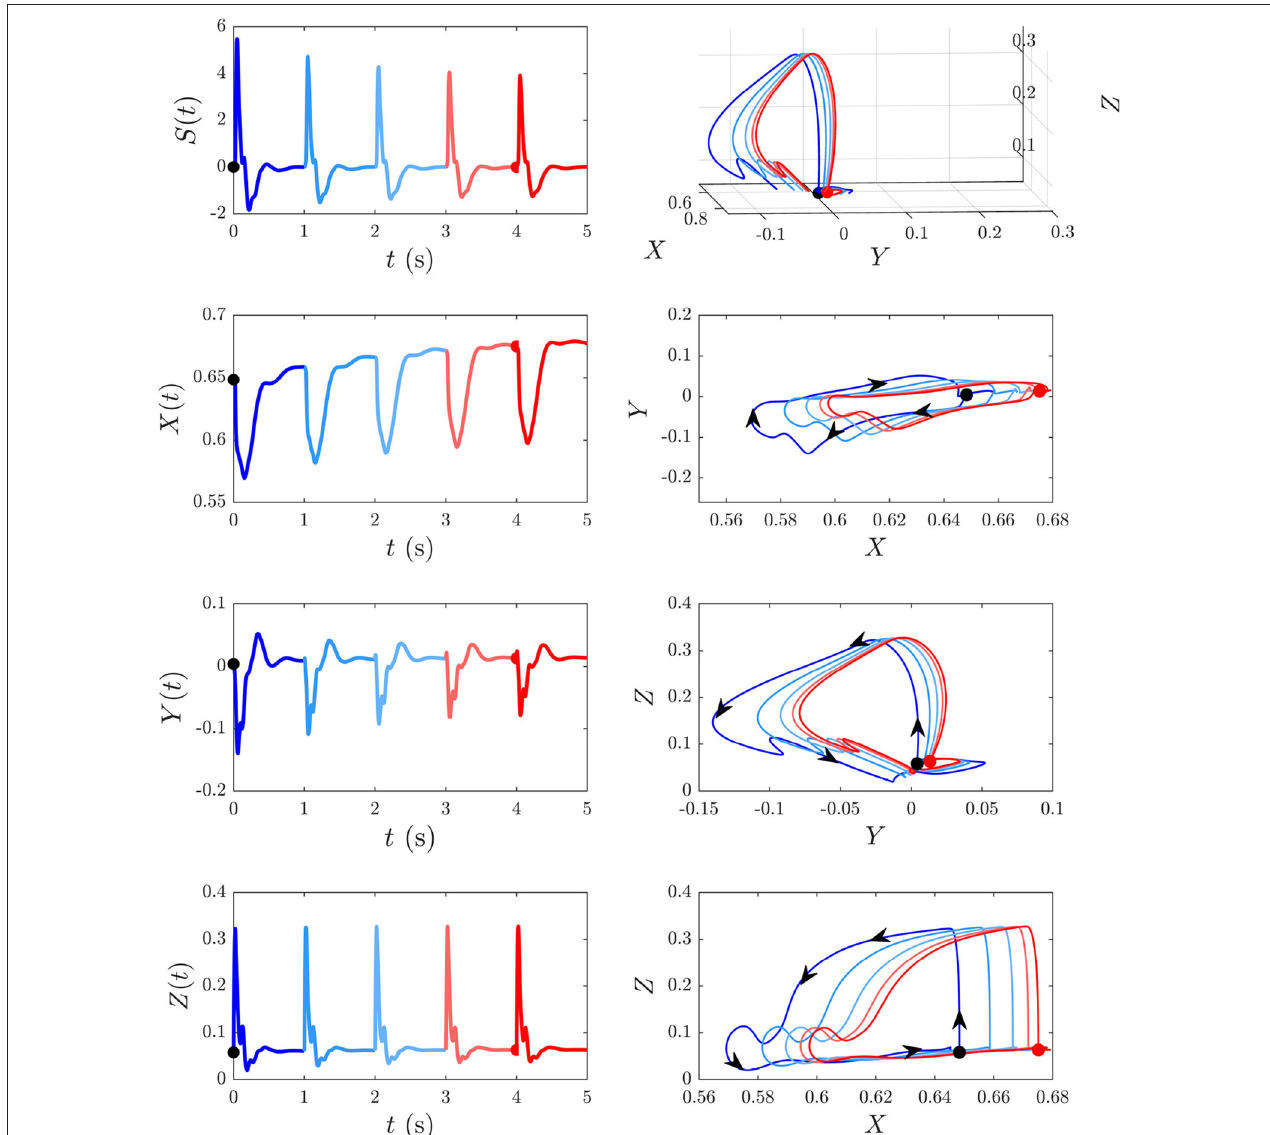
FIGURE 9 | Development of the S response from Figure 6B and its associated trajectories in XYZ space. The black dot indicates the start point at baseline P and ∞ the red dot indicates the start point S . First column shows the evoked response from Figure 6 , and the corresponding X ( t ), Y ( t ), and Z ( t ) curves ( X , Y , and Z are ∞ intracortical, corticothalamic, and intrathalamic loop strengths, respectively). Second column shows this trajectory in XYZ space, and in the XY , YZ , and XZ planes where the arrows indicate the direction of